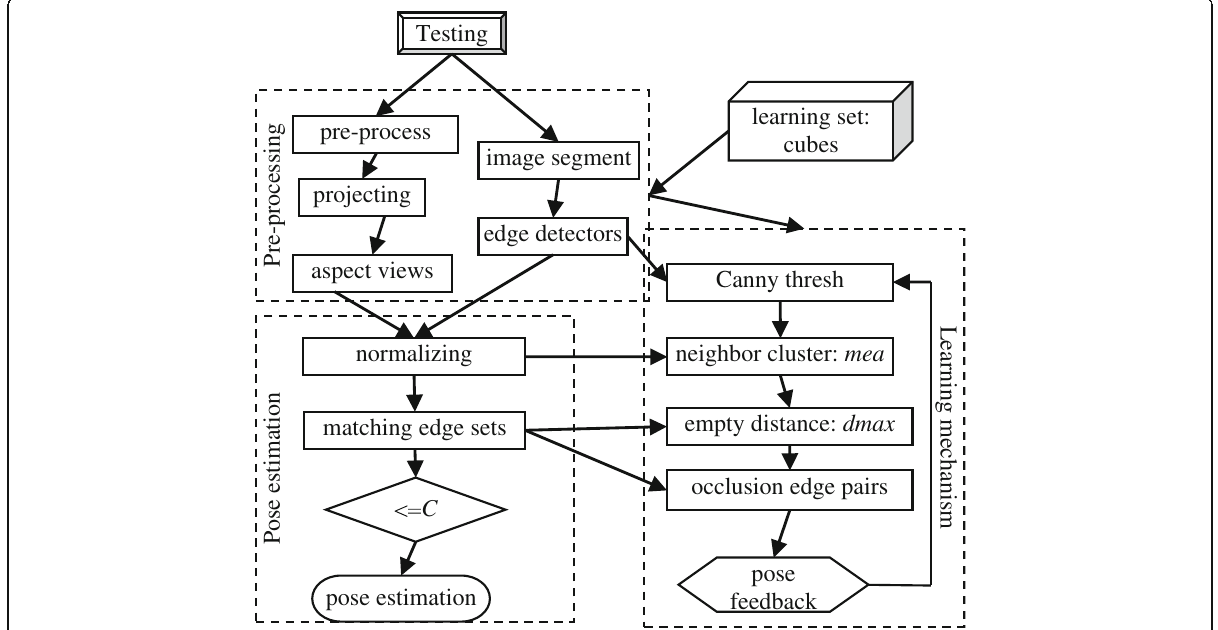
Fig. 6 The learning mechanism of pose